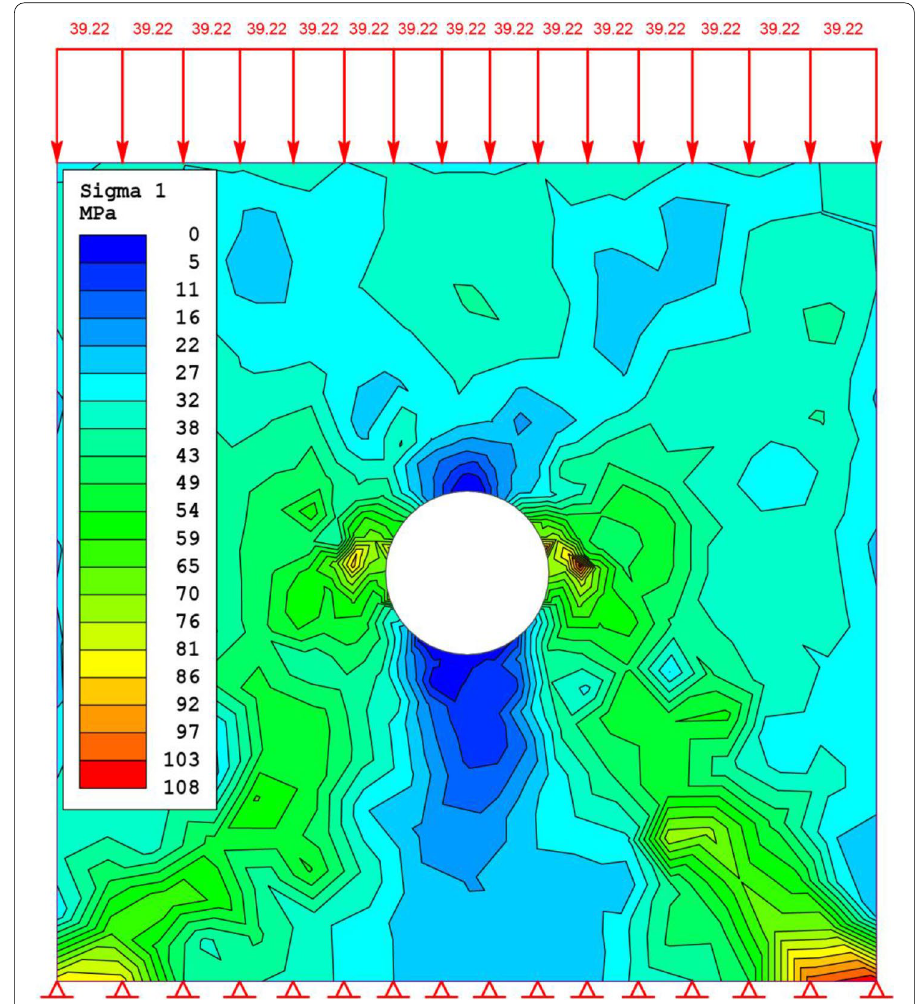
failure process of the rock tunnel subjected to vertical loading. The fracturing images and AE signals were simultaneously recorded. The AE results of the three cases (viz intact, horizontal joint set, and vertical joint set) has been carefully studied. The fol- lowing conclusion can be drawn from the experimental